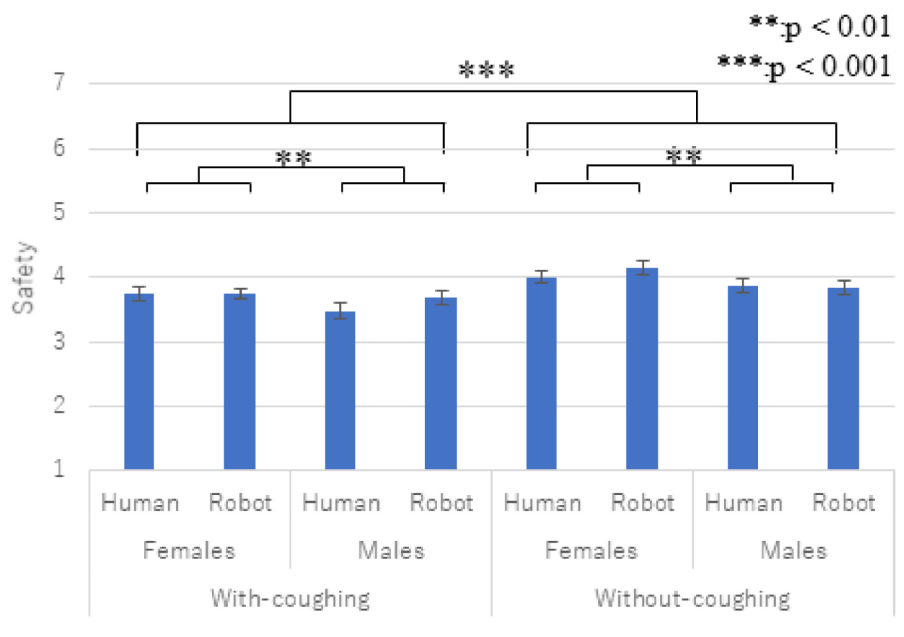
Fig 7. Average and S.E of safety. The gender and coughing factors showed significant main